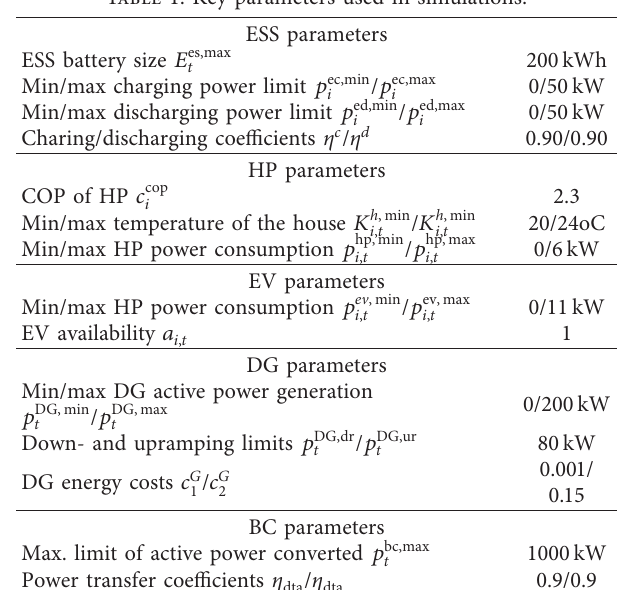
Table 1: Key parameters used in simulations.